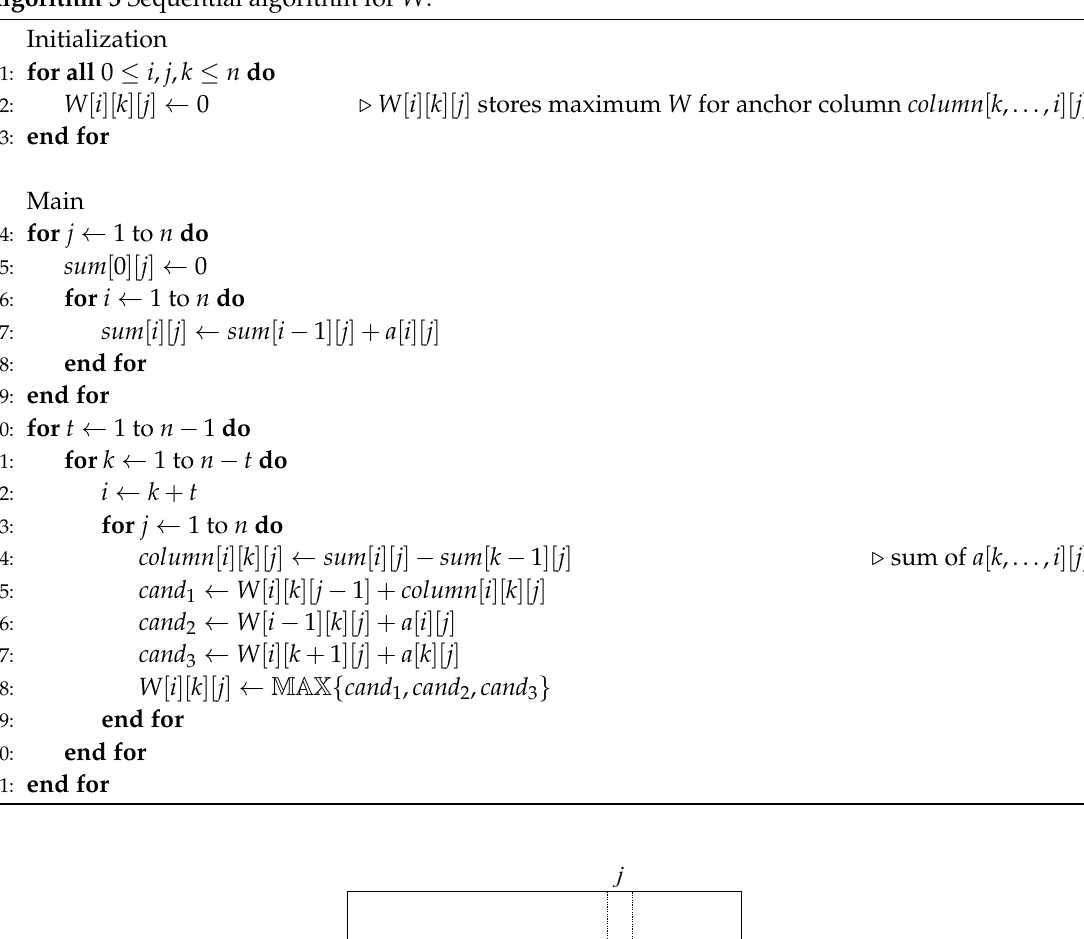
Algorithm 5 Sequential algorithm for W .